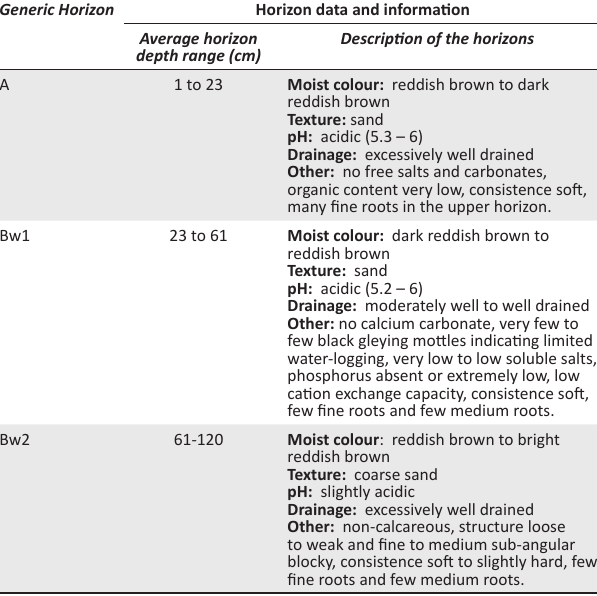
TABLE A1.7b: Differentiating characteristics of the ferralic Arenosols.